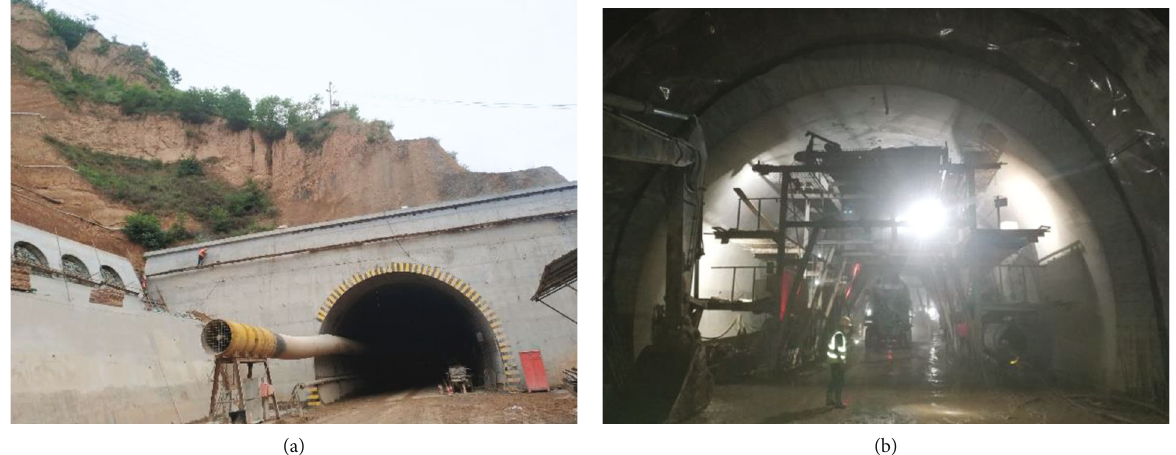
Figure 3: Construction situation (a) outside and (b) inside the tunnel before the incident.